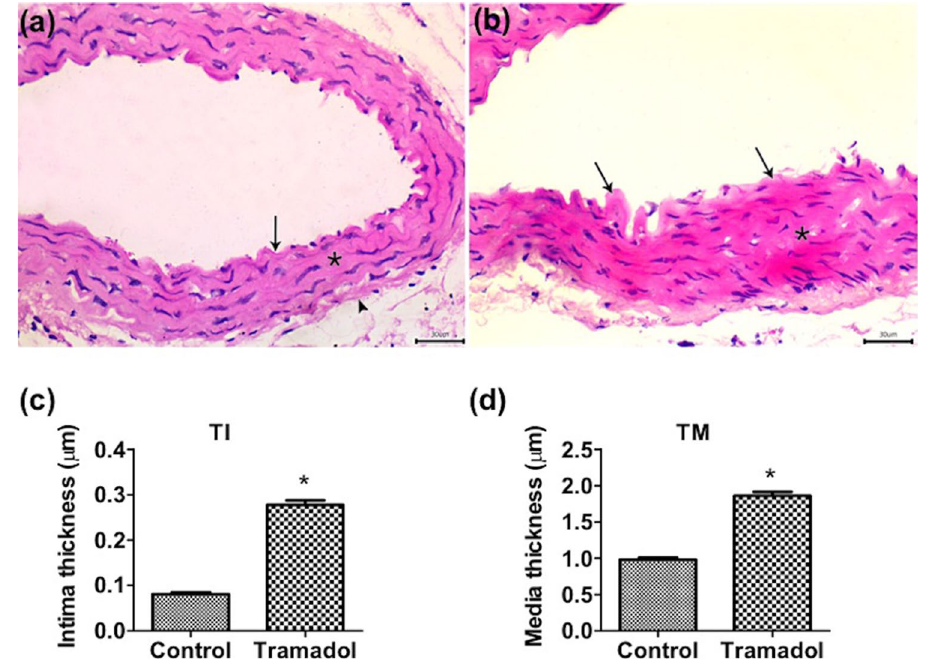
Figure 4. Photomicrographs in a section of thoracic aorta stained with hematoxylin and eosin stains (×400). ( a ) Normal morphology of aortic wall of the control group with tunica intima (arrow), media (asterisk), and tunica adventitia (arrowhead) are seen. ( b ) Tramadol treated group showing thickening of tunica intima (arrows). The irregular arrangement of smooth muscle fibers and elastin lamella of tunica media is seen (asterisk). ( c ) Graphical representation of thickness of the tunica intima (TI) of the thoracic aorta of control and tramadol mice. ( d ) Graphical representation of the thickness of the tunica media (TM) of the thoracic aorta of control and tramadol treated mice. n = 10. Values represent mean ± SEM. *p < 0.05 for control versus